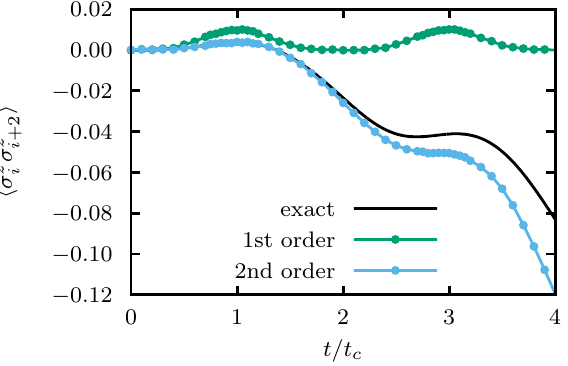
Figure 6: MC data from pCN in comparison with exact results for different h / J in d = 1. The left column shows magnetization 〈 σ x 〈 σ z σ z 〉 . i i + 1